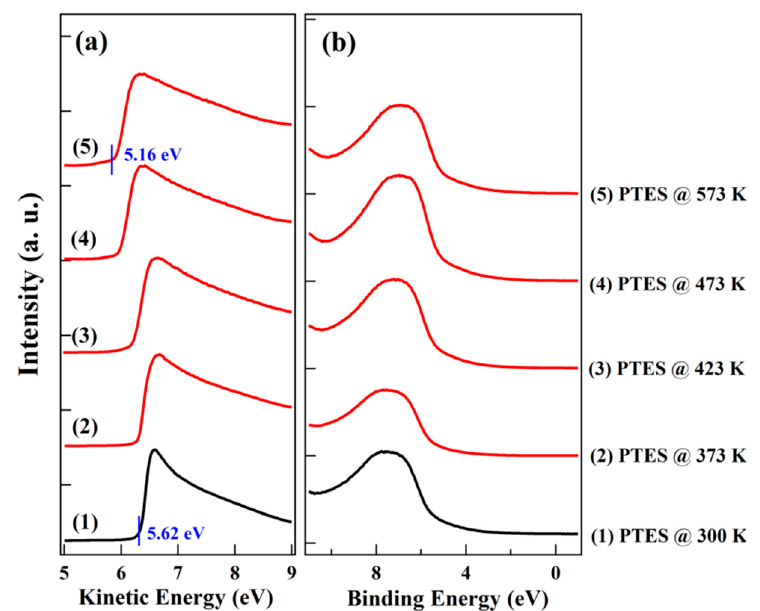
Figure 5. Spectra at the ( a ) secondary electron cut-off and ( b ) valence band region for PTES as a function of vacuum annealing temperature.